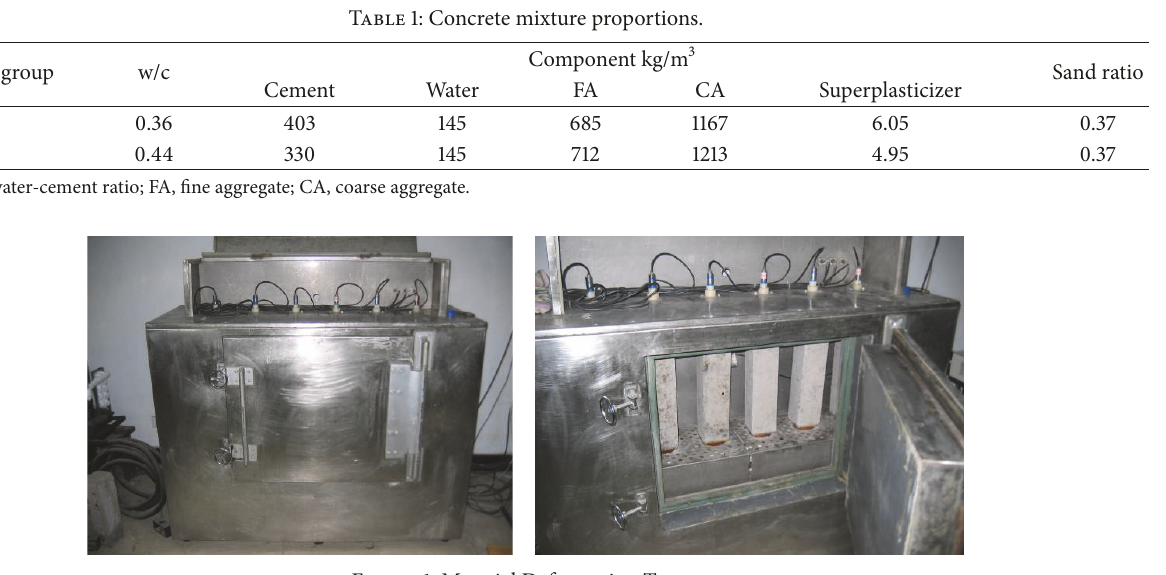
Figure 1: Material Deformation